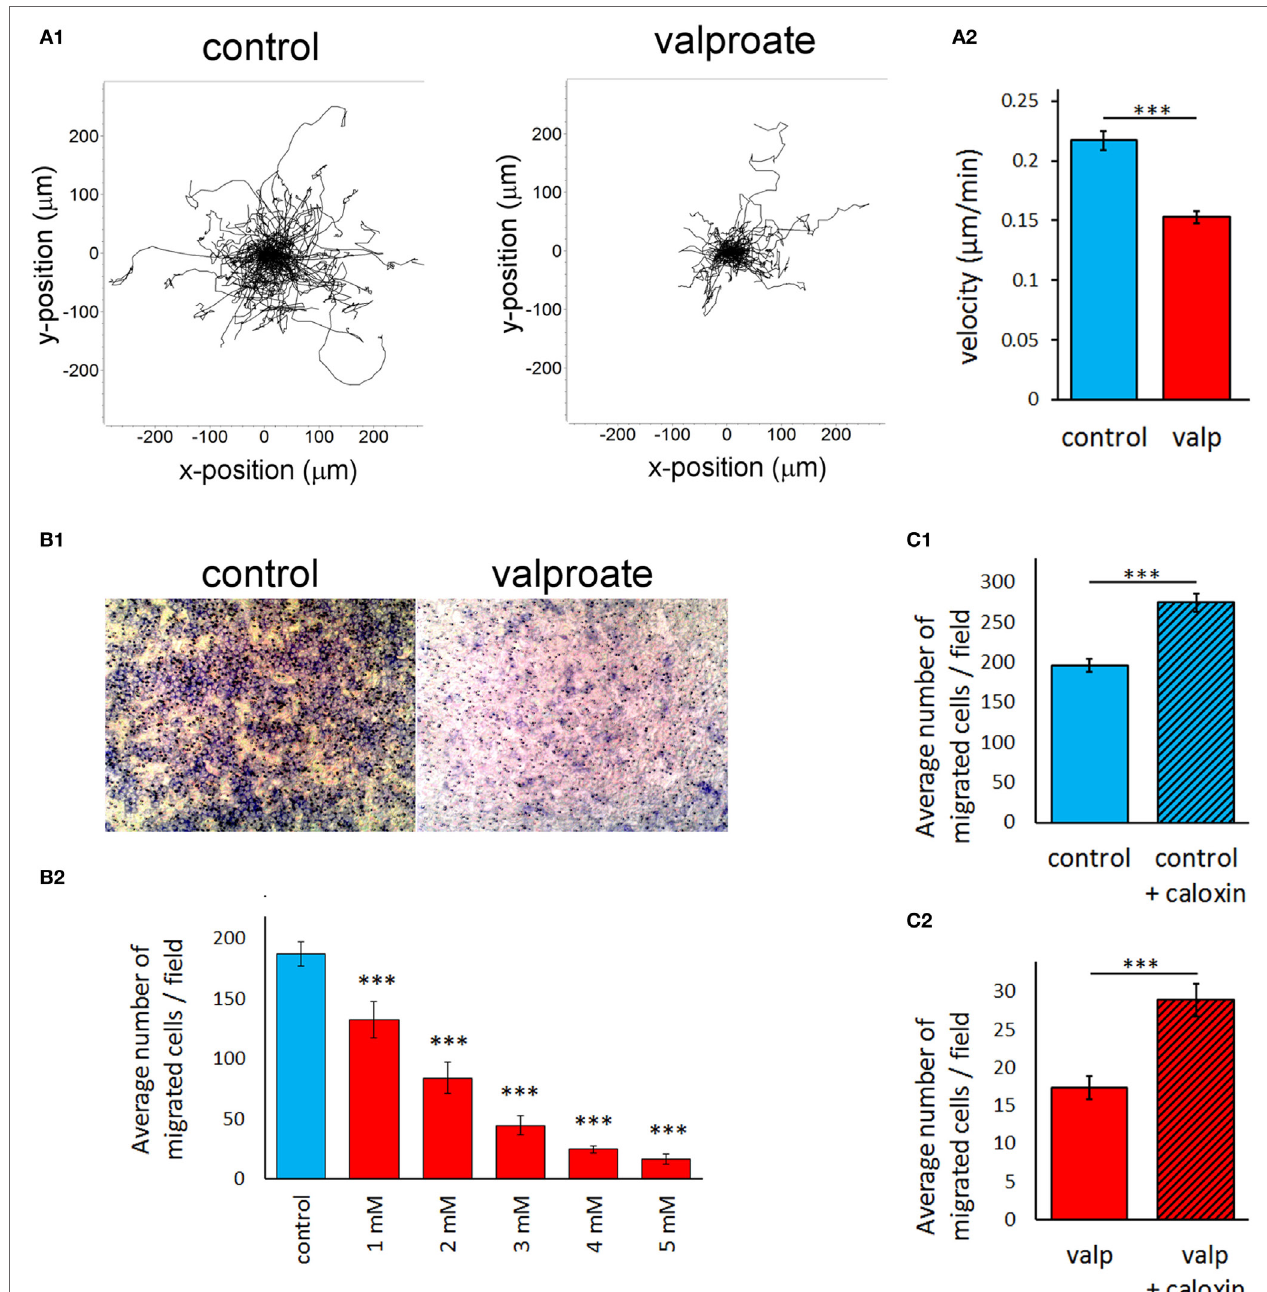
FigUre 6 | histone deacetylase inhibitor treatment strongly decreases the migratory activity of a375 melanoma cells in a PMca4b-dependent manner . A375 cells were treated with 4 mM valproate for 48 h before the migration analysis. (a) The random migratory activity of A375 melanoma cells was analyzed by automated fluorescence microscopy for 24 h (A1). Single cell migration trajectories of untreated, control cells (left graph) and valproate-treated cells (right graph) were recorded. Starting position of each cell trajectory was fixed to the origin of the plot. (A2) Mean velocity was evaluated for 24 h of migration. Data are shown as mean ± SEM of ≥ 100 individual cells of at least three independent measurements. Significance compared to control is denoted by *** p < 0.001; two-tailed unpaired t -test. (B,c) . Effect of valproate treatment of A375 cells (B) and specific inhibition of PMCA4 with caloxin 1c2 (c) on the directional migration of A375 cells. The effect of PMCA4 inhibition was studied on untreated (C1) and 4 mM valproate-treated (C2) A375 cells. The directional migration activity was assessed using Boyden chambers. B1 images show representative fields of view from the bottom of the filter (control and 4 mM valproate-treated A375 cells). B2 shows migration of cells in response to different concentrations (1–5 mM) of valproate. The cells that migrated through the membrane to the bottom face were counted. The bar graphs (B2, C1, C2) indicate the average number of migrated cells per field. Data are mean of three experiments ± SEM. Significance of comparisons is denoted by *** p < 0.001; two-tailed unpaired t -test.